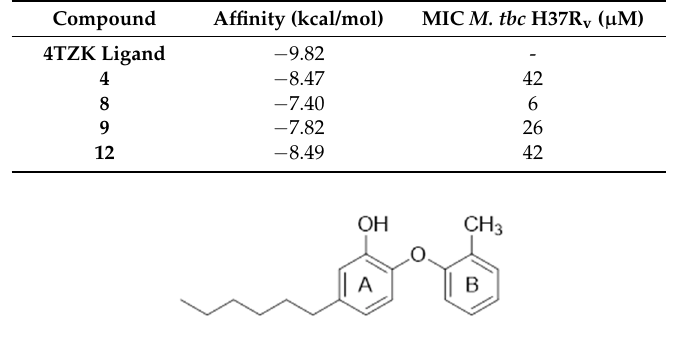
Figure 5. Chemical structure of PT70.